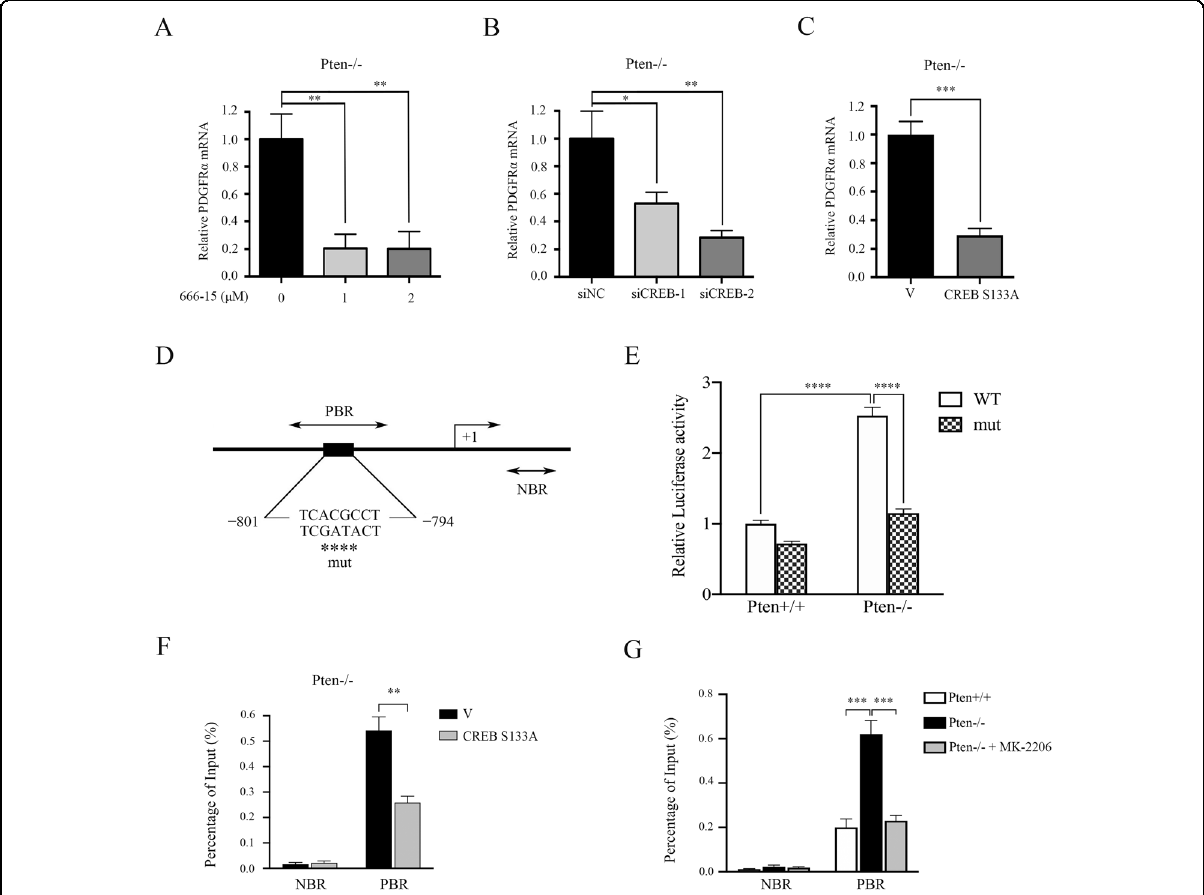
Fig. 3 CREB promotes PDGFR α transcription. A Pten − / − MEFs were treated with or without 666-15 (1 or 2 μ M) for 24 h. B Pten − / − MEFs were transfected with siNC, siCREB-1, or siCREB-2 for 48 h. C , F Pten − / − MEFs transduced with the retroviruses for CREB S133A in pLXIN or its control vector pLXIN (V). A – C The mRNA level of PDGFR α was detected by qRT-PCR. D Schematic representation of the putative wild-type (WT) and mutated (mut) CREB-binding sites in the promoter of the mouse PDGFR α gene. E The wild-type (WT) reporter plasmid pPDGFR α -Luc or the mutated (mut) reporter plasmid (pPDGFR α mut-Luc) were co-transfected with Pten + / + or Pten − / − MEFs with pRL-TK plasmid. Relative luciferase activity was detected 24 h after transfection. G Pten + / + , Pten − / − and MK-2206-treated (5 μ M, 24 h) Pten − / − MEFs. F , G The indicated cells were subjected to a ChIP analysis of CREB binding site in PDGFR α promoter region using an anti-phospho-CREB (Ser 133 ) antibody. Normal rabbit IgG antibody served as negative control. qRT-PCR was performed to amplify regions surrounding the putative CREB binding region (PBR) and a nonspeci fi c CREB binding region (NBR). The data were plotted as the ratio of immunoprecipitated DNA subtracting nonspeci fi c binding to IgG vs. total input DNA (%). Representative data from three independent experiments are shown. Error bars indicate mean ± SD of triplicate samples. * P < 0.05; ** P < 0.01; *** P < 0.001; **** P <